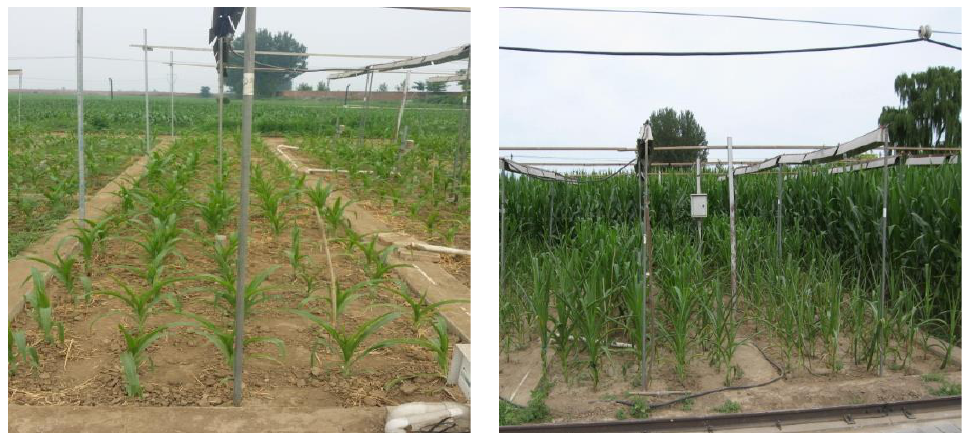
Figure 2. Layout of instruments in the experimental plot.